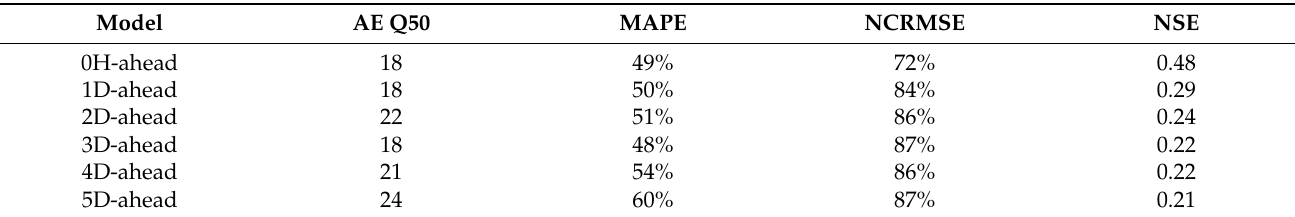
Figure 5. OPM model performance for different lead-time forecast weather for forecast events. ( a ) Scatter plot of OPM performance for the forecasted weather at lead times from five days to zero hour, ( b ) Scatter plot of OPM performance for the forecasted weather at zero hour. Table 3. Model performance of the OPM for forecast weather at different lead times.